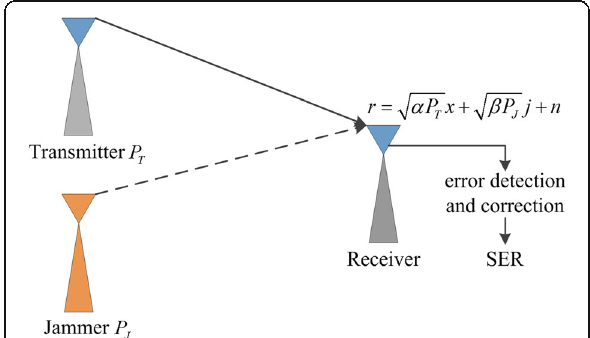
p ffiffiffiffiffiffiffiffiffiffi ffiffiffiffiffiffiffiffiffiffiffiffiffiffiffi ϕ P T þ